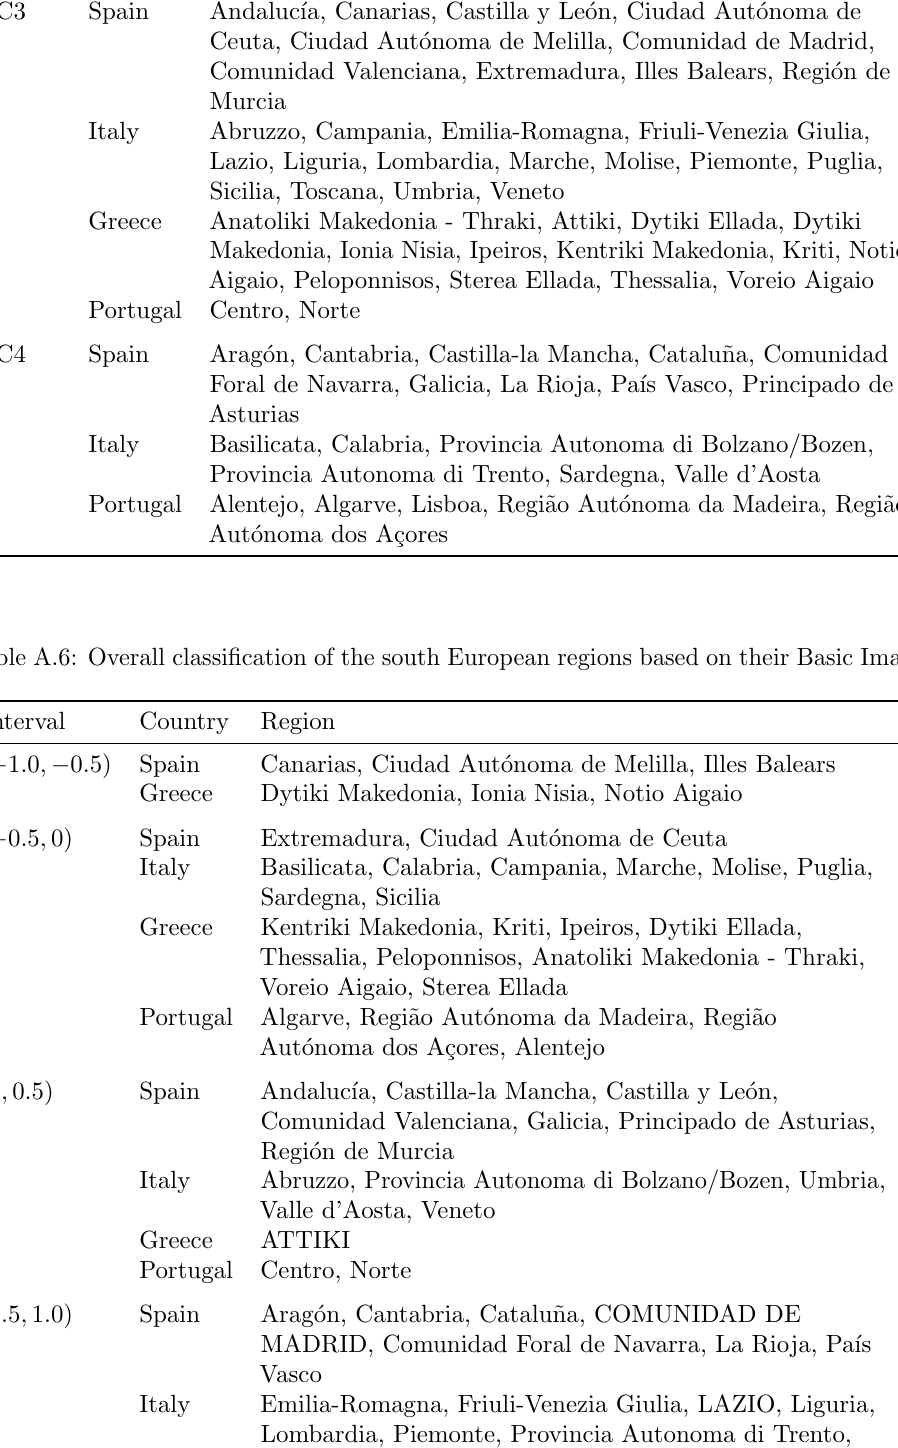
Table A.5: Clustering based on Poverty and Environmental characteristics of the south European regions Cluster